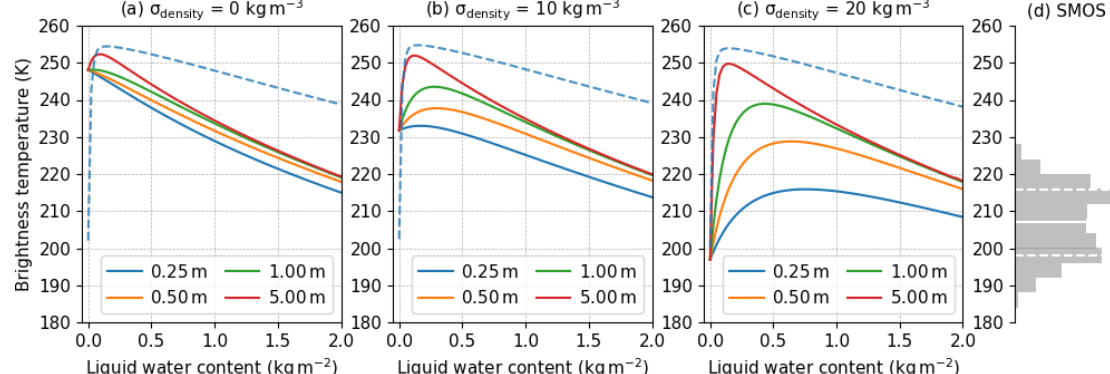
Figure 7. (a–c) DMRT-ML brightness temperature at H polarization (K) as a function of liquid water content for several wet-snow thick- nesses in the upper snowpack (colours) at 1.4GHz (solid lines) and 0.25m of wet snow at 19GHz (dashed line), with three density variabil- ities ( σ density ). (d) Daily winter SMOS observations distribution (see text for details), with mean (white solid) and standard deviation (white dashed).